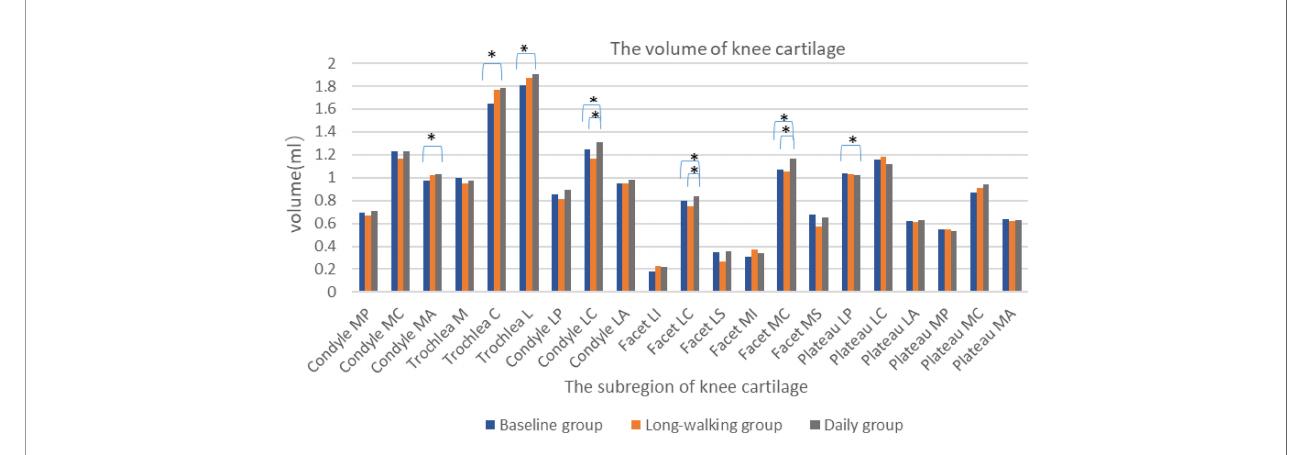
FIGURE 5 | Histogram of volume changes in the sub-regions of the knee cartilage in the three groups. * Indicates statistical signi fi